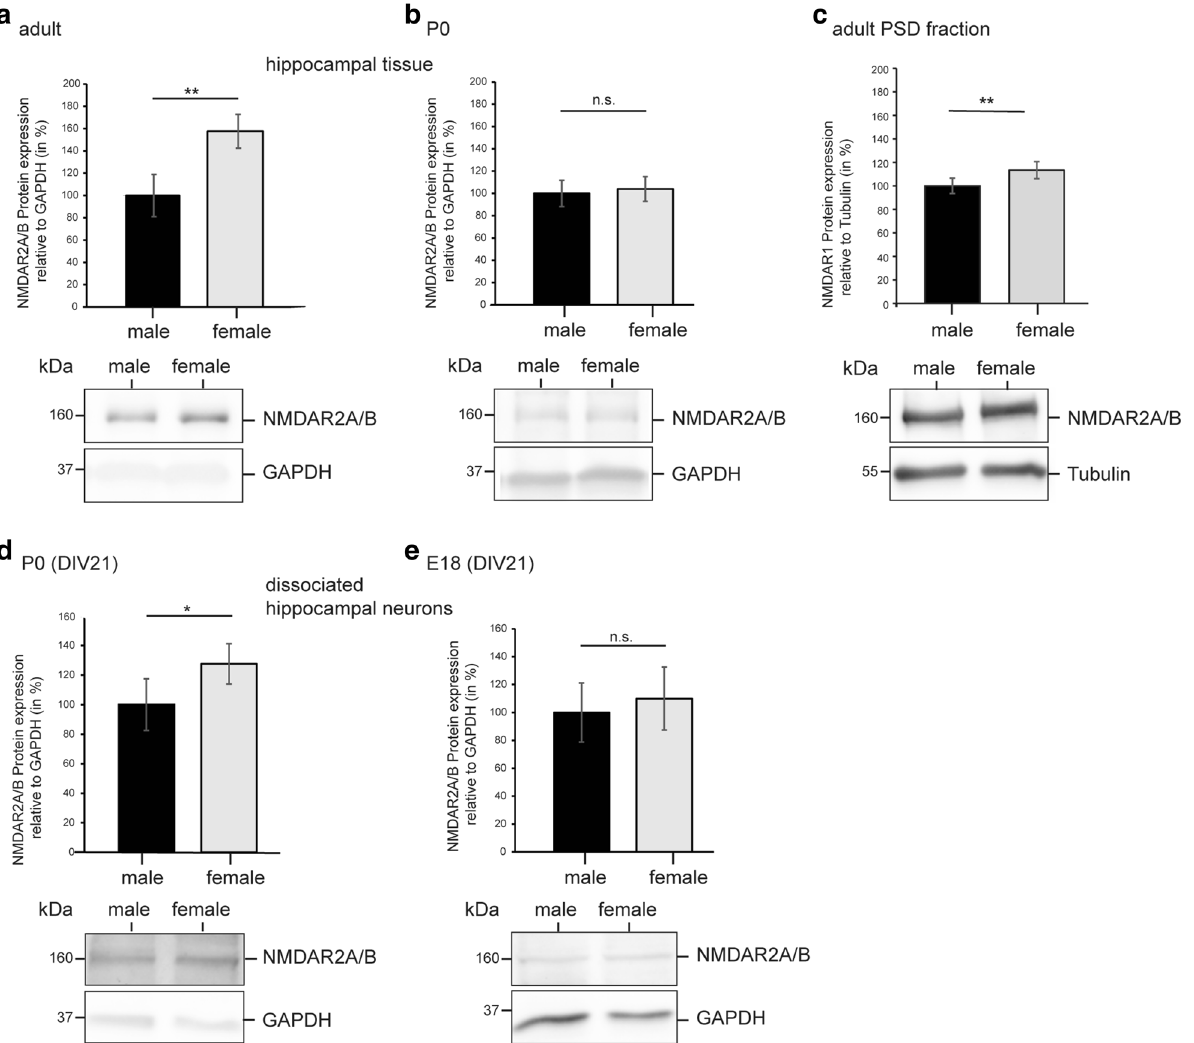
Figure 4. Western blot analyses of endogenous NMDAR2A/B levels in hippocampal tissue or of cultured hippocampal neurons. All immunoblots were probed with either anti-NMDAR2A/B antibody (~ 160 kDa) or anti-GAPDH monoclonal antibody (loading control; ~ 37 kDa). Protein levels were quantified and normalized according to the levels of GAPDH protein. Abbreviations: P0 (postnatal day 0), E18 (embryonic day 18), DIV (days in vitro). Please note that different exposure times are shown. Data are normalized to male levels. ( a ) Quantitative analysis of hippocampal tissue of adult male and female mice revealed stronger expression of NMDAR2A/B in female mice (**p = 0.002; Mann–Whitney U test; male: n = 6 animals with n = 9 blots, female: n = 8 animals with n = 9 blots). ( b ) Quantitative analysis of P0 hippocampal tissue of male and female mice revealed no difference in NMDAR2A/B expression (p = 0.419; Mann–Whitney U test; male: n = 10 animals with n = 10 blots, female: n = 8 animals with n = 10 blots). ( c ) The adult female hippocampal PSD fraction displays more NMDAR2A/B receptors than the male hippocampal PSD fraction. Western blot analyses of endogenous NMDAR2A/B levels in hippocampal PSD fraction. All immunoblots were probed either with anti- NMDAR2A/B antibody (~ 160 kDa) or anti-Tubulin monoclonal antibody (loading control; ~ 55 kDa). Protein levels were quantified and normalized according to the levels of Tubulin protein (**p = 0.014; Student’s t-test; male: n = 14 animals used for PSD preparation with n = 7 blots, female: n = 15 animals used for PSD preparation with n = 7 blots). ( d ) Quantitative analysis of male and female hippocampal neurons at DIV21 (preparation day P0) revealed stronger expression in NMDAR2A/B expression in hippocampal cultures (*p = 0.015; Mann–Whitney U test; n = 4 independent cultures per sex with n = 8 blots). ( e ) No significant difference in NMDAR2A/B expression was observed in male and female hippocampal neurons in culture at DIV21 (preparation day E18 p = 0.369; Mann–Whitney U test; n = 4 independent cultures per sex with n = 8